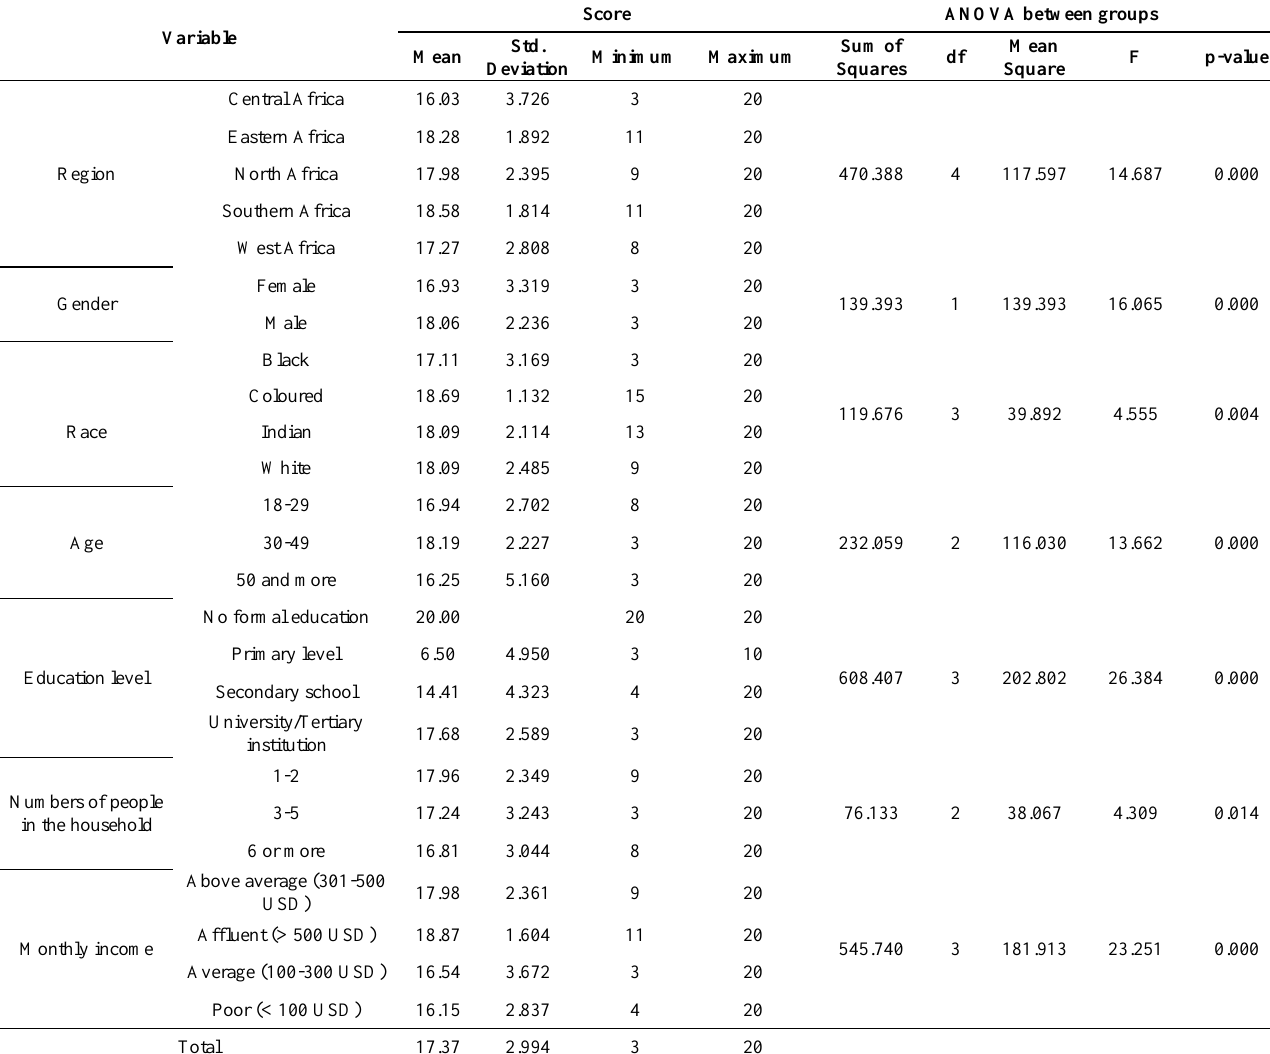
Table 1. Change of CSI score with the sociodemographic variables (N=460)